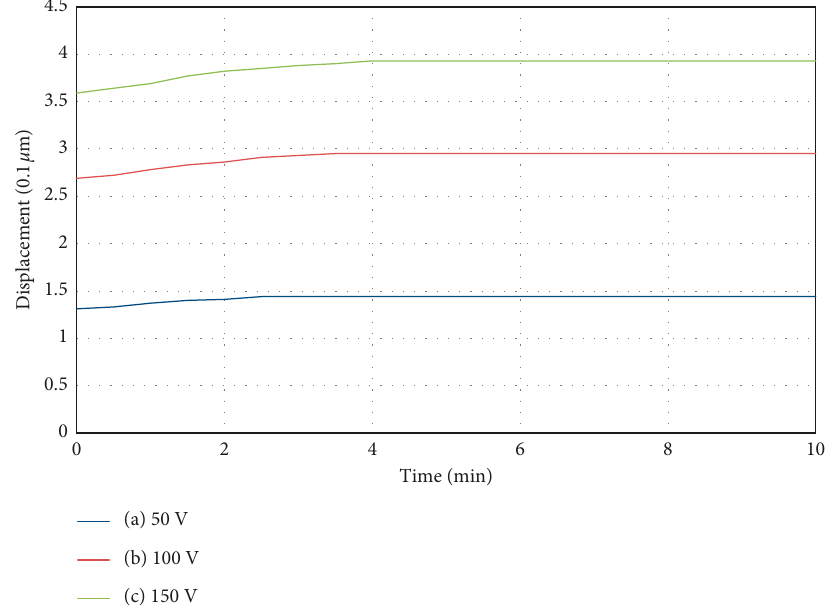
Figure 5: Creep of KNN element in the asphalt concrete under different